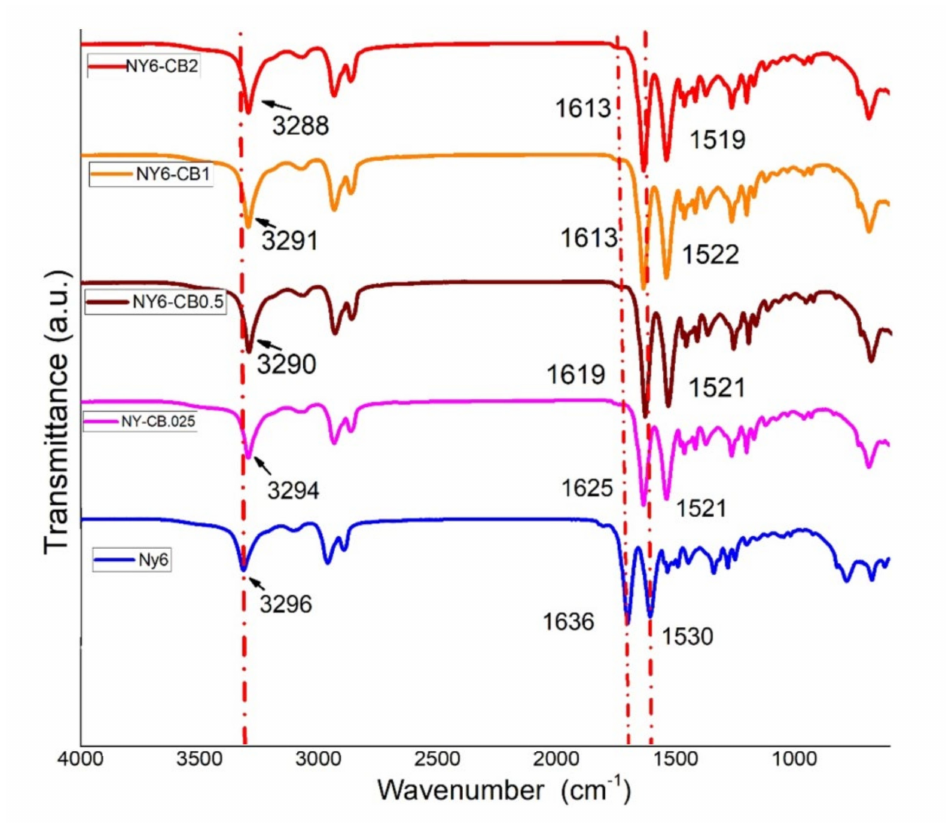
Figure 5. FTIR spectra of the Nylon 6 and NY6 / MCB60